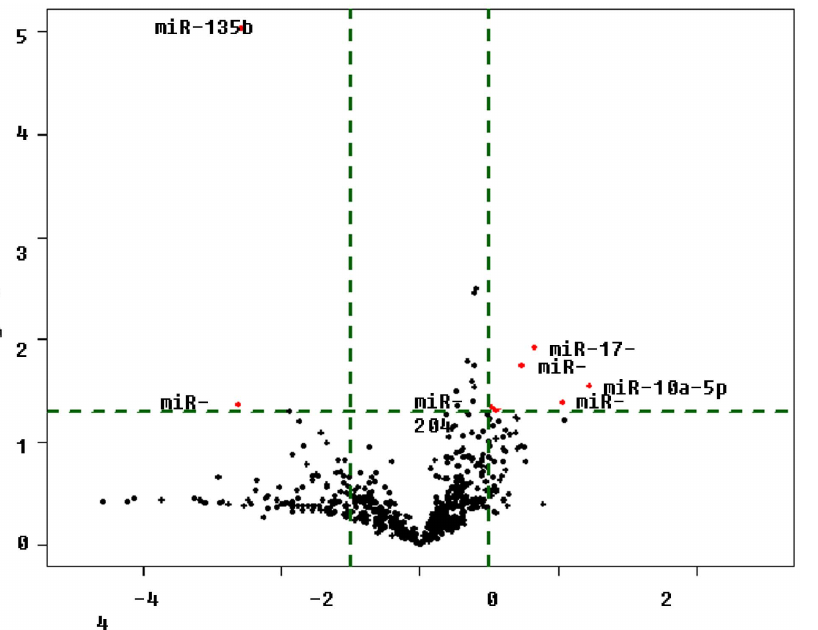
Figure 4. The Volcano Plot graph of miRNA array. This graph shows that log 2 of the fold change in each miRNA’s expression between AcarH group and DM group is versus its -log 10 of P value from the t -test. The vertical green line indicate that the fold change in miRNA expression threshold is 2. The horizonal green lin indicates that the P value of the t -test threshold is 0.05. There were 8 miRNAs which showed significantly different expression between AcarH group and DM group.